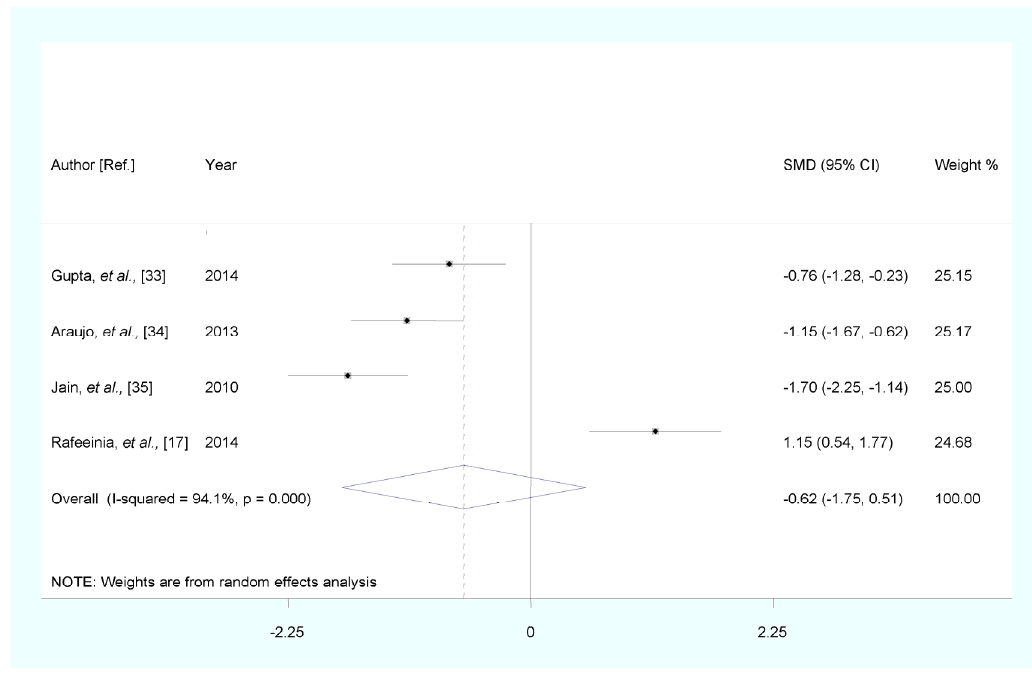
Figure 4. Forest plot of standard mean difference (SMD) with corresponding 95% confidence interval (CI) of studies on zinc levels in severe preeclampsia (PE) and healthy pregnancy controls. The size of grey box is positively proportional to the weight assigned to each study, and horizontal lines represent the 95% CIs.